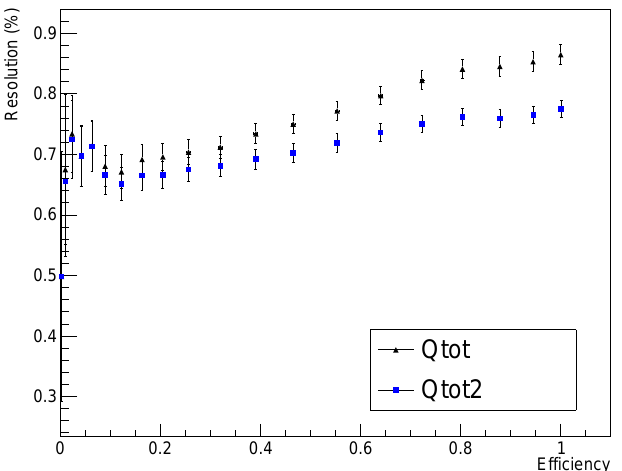
Figure 7. Application of a geometrical cut for photons to reject events close to the edge, based on the position